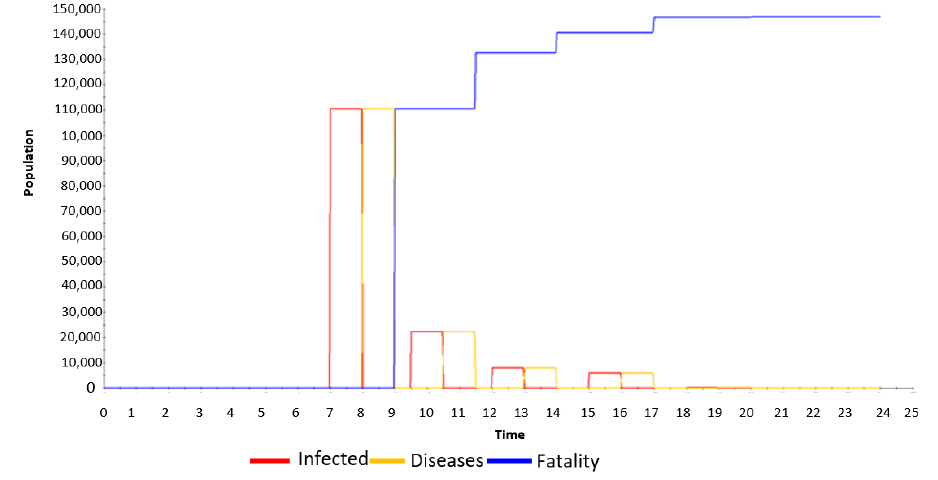
Figure 7. Estimated infection, disease, and fatalities (contamination at